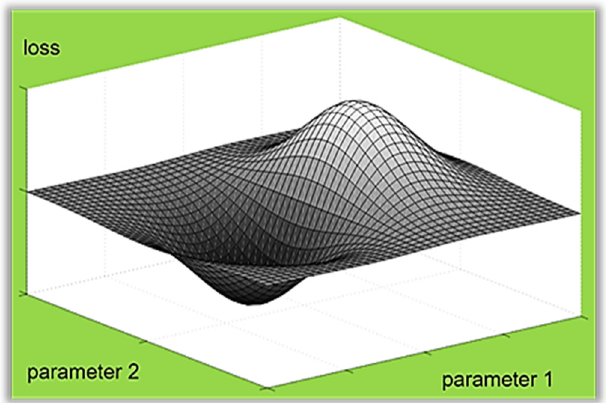
Figure 1. Loss index viewed as a hyper-surface with parameters as coordinates.